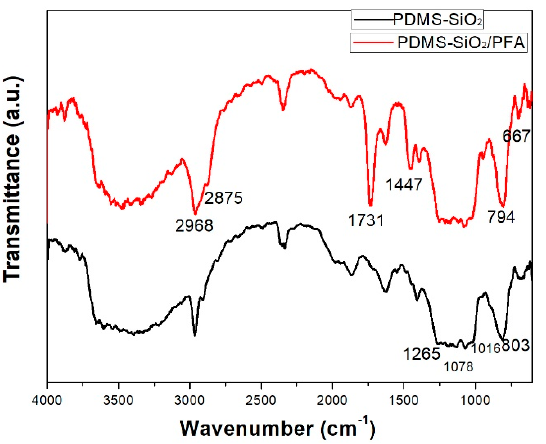
Figure 4. Fourier transform infrared (FTIR) spectra of PDMS-SiO 2 and PDMS-SiO 2 /PFA with a mass ratio of PDMS-SiO 2 to PFA of 0.5.